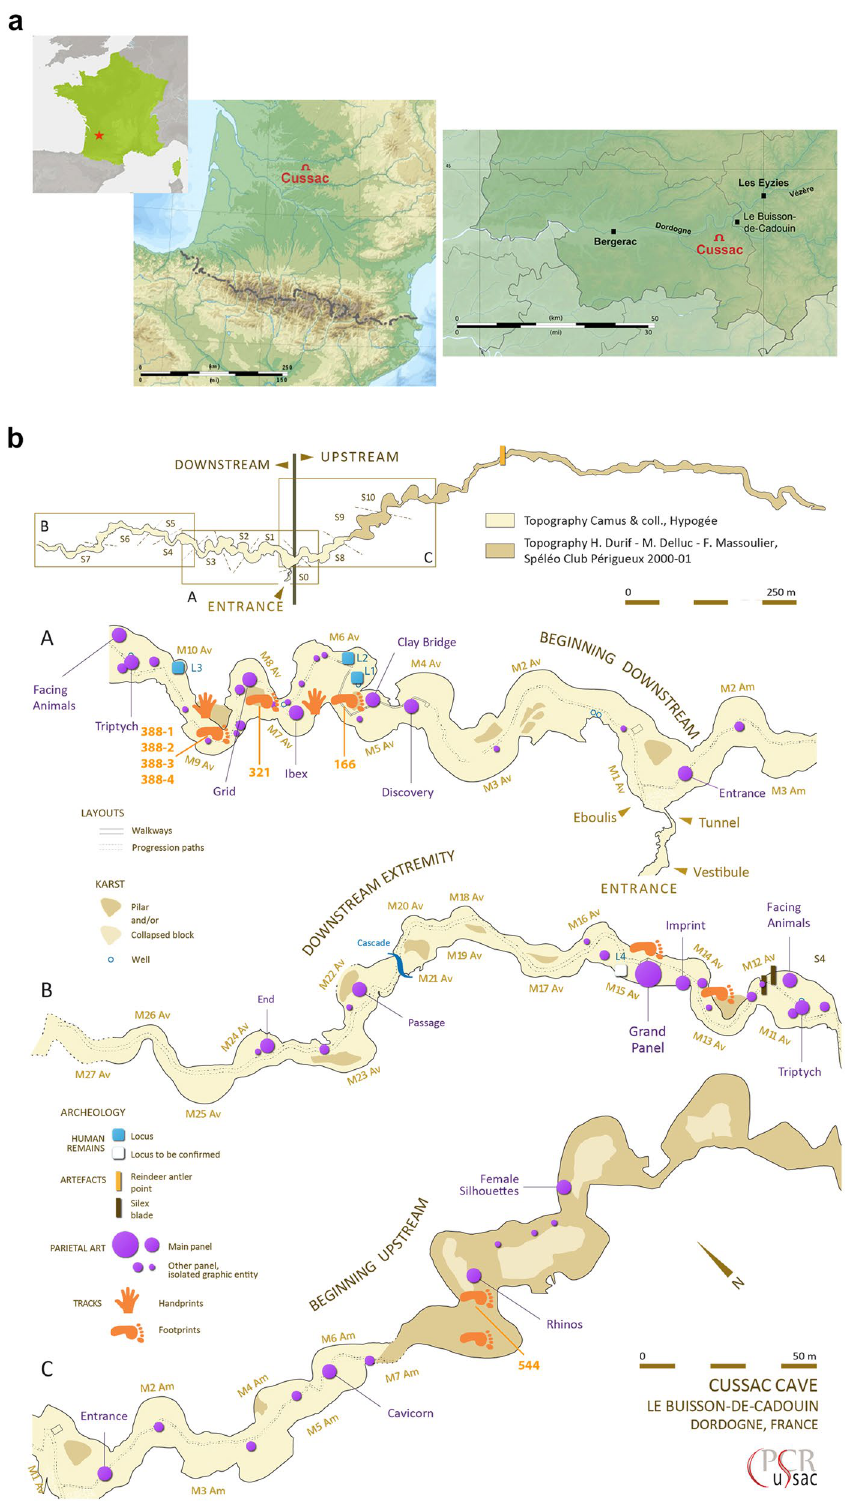
Figure 1. Location and topography of Cussac cave. ( a ) Geographic location of Cussac Cave. ( b ) General topography of Cussac Cave (PCR Cussac, doc. H. Camus, Protée, CAD Fr. Lacrampe-Cuyaubère) and location of the tracks (generated in Illustrator v.16.0.0, https:// www. adobe. com/ fr/ produ cts/ illus trator.